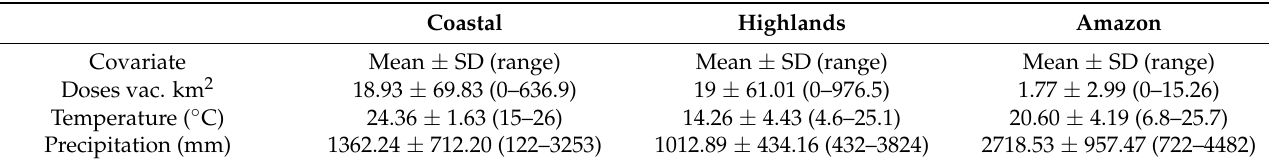
Table 6. Descriptive measures of covariants of the spatiotemporal model in Ecuador. Coastal